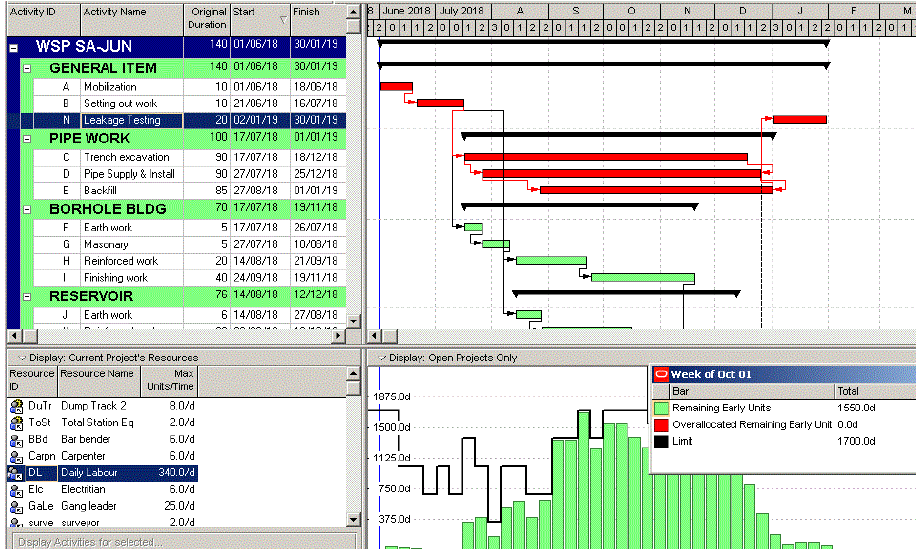
Fig. 6. Weekly DL usage (normal time) for June commencement date (developed by the